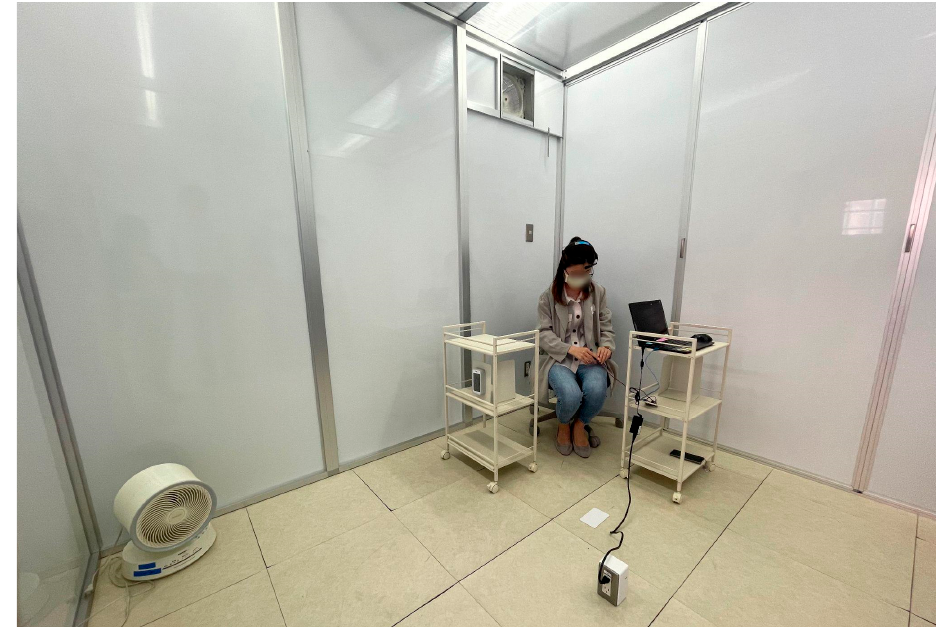
Figure 2. Experiment room.